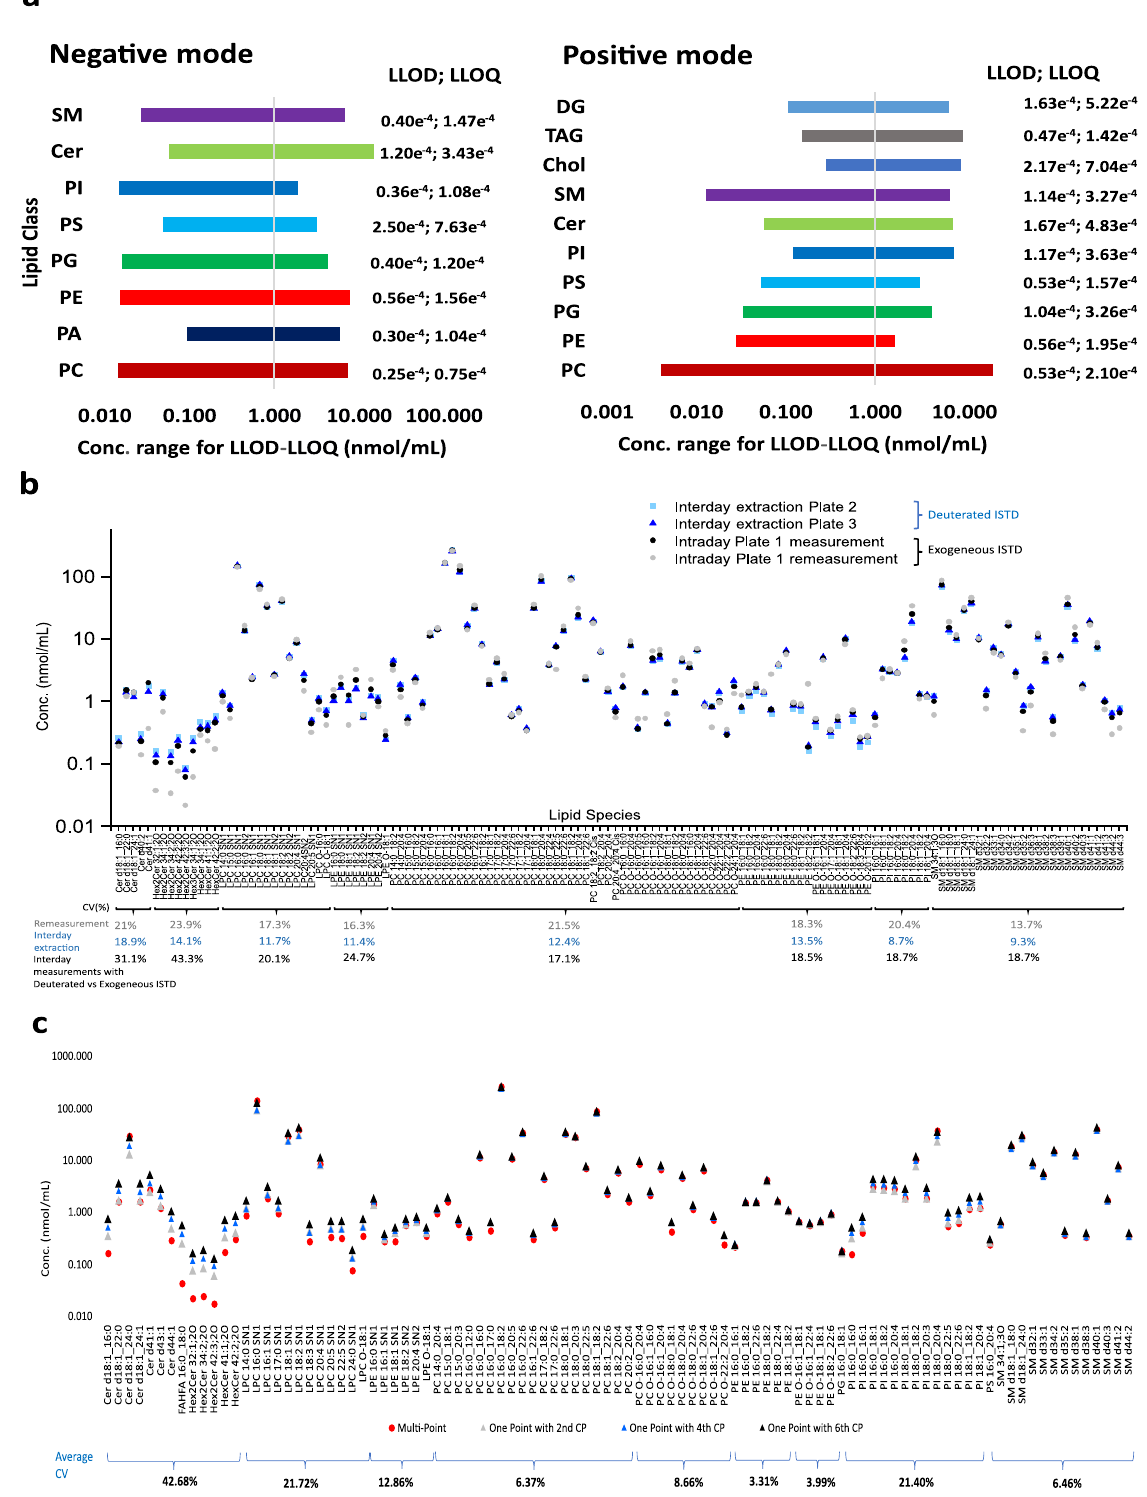
NIST plasma and serum SRM lipidome quanti fi ed by high- throughput 4D lipidomics platform 359 out of 370 lipids annotated with high-con fi dence in NIST plasma SRM were reproducibly ( n =32 and n =64) quanti fi ed with the 4D lipidomics quanti fi cation strategy, i.e., multi-point quanti fi cation of TOF MS-survey data using level-3 ISTDs (Supplementary Data 6 and 7). 354 lipids were quanti fi ed in NIST serum SRM (Supplementary Data